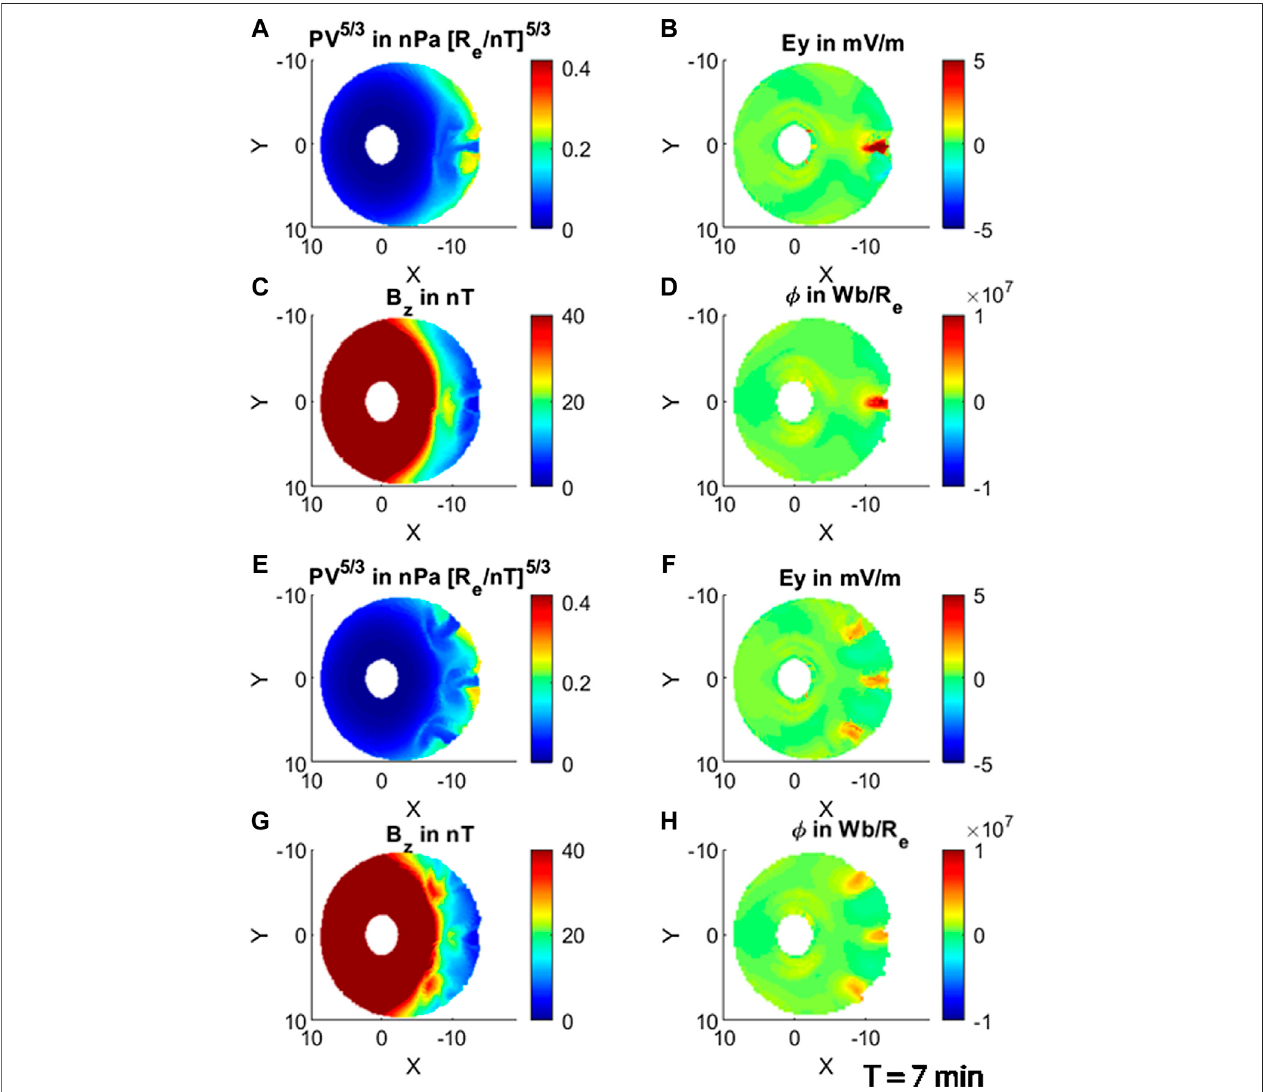
FIGURE 9 | Similar to Figure 2 or Figure 3 , from A – D is for the single fl ow channel and E – H is for the three fl ow channels at T (cid:1) 7 min.